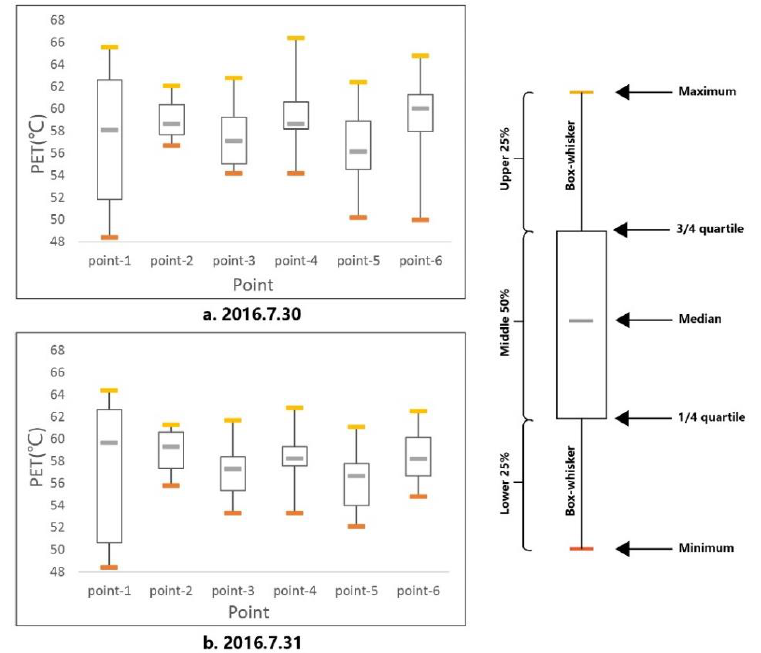
Figure 13. The PET of the selected points at 3:00 pm. ( a ): First day; ( b ): Second day.